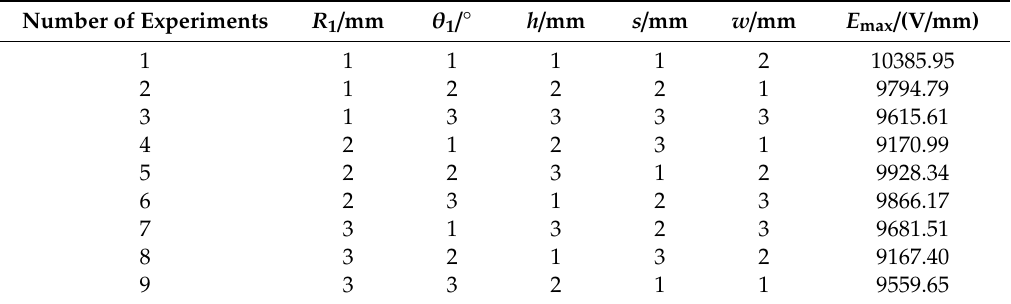
Table 3. Orthogonal matrix and results of L 9 (3 5 Table 2. Parameters to be optimized and impact factors.